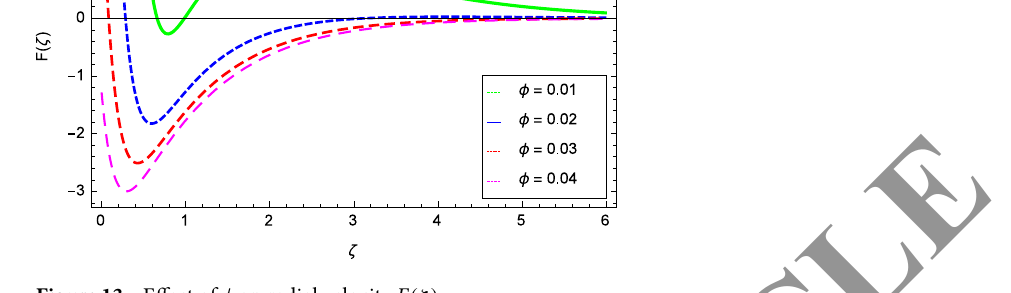
Figure 13. Effect of φ on radial velocity F (ζ) .